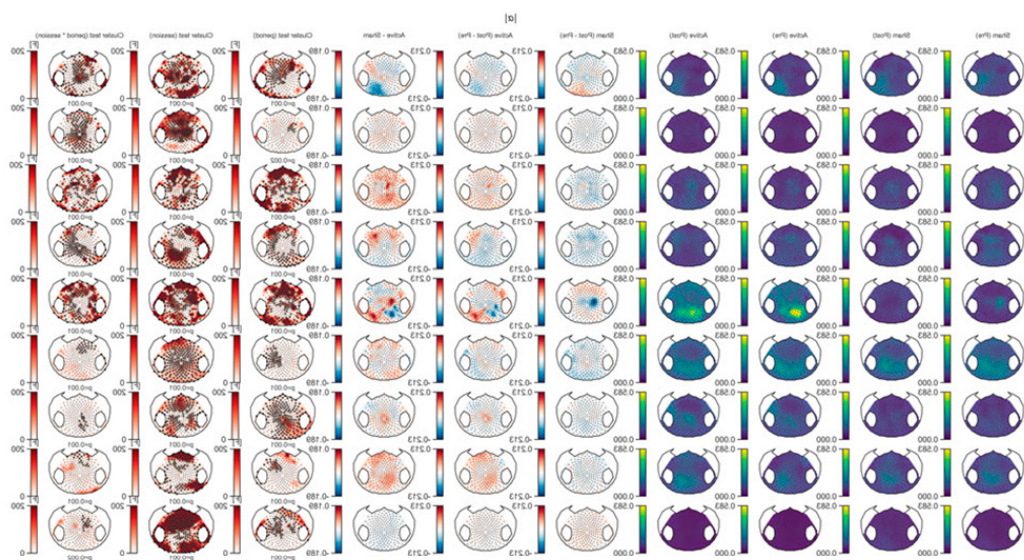
Figure A3. Spectral Power Variability of the Alpha Band at the Subject Level. The first four columns show the mean power over the epochs for each session and period. Columns 5 and 6 show the power difference in the sham and active sessions, respectively. Column 7 shows the difference between active and sham sessions (i.e., (post-pre)Active–(post-pre)sham). Columns 8 to 10 show the results of the permutation cluster test on the F values of the ANOVA model to test the significance of the effects of period (post vs. pre), session (sham vs. active), and their interaction, respectively.